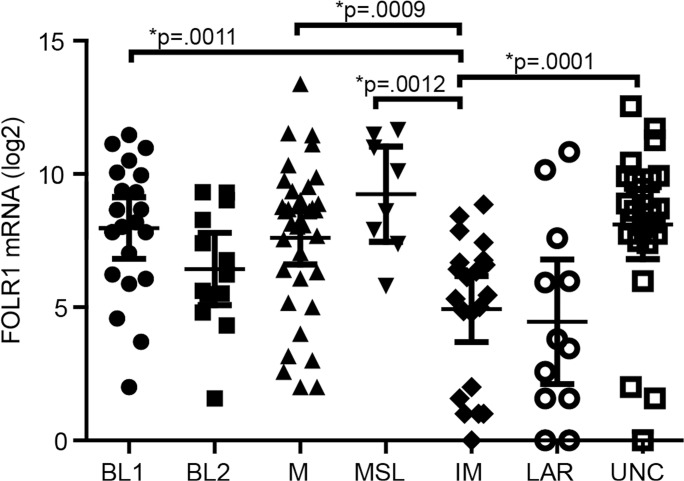
Distribution of FOLR1 tumor expression across TNBC tumor subtypes.
FOLR1 mRNA expression from 131 TN tumors from TCGA RNA-seq dataset were plotted versus the six TNBC subtypes that include basal-like (BL1 and BL2), immunomodulatory (IM), mesenchymal (M), mesenchymal stem-like (MSL), and luminal androgen receptor (LAR) reported by Lehman et al. [9]. Tumors were assigned to an unclassified group (UNC) if they had low correlations (<0.1) for any subtype or were similar between multiple subtypes (P<.05) [9]. Statistical significance across groups was determined by ANOVA Kruskal-Wallis test followed by Dunn’s Multiple Comparison Post test. *Significance at the P values shown was confirmed by Mann Whitney test of IM versus BL1, BL2, M, MSL, and LAR subtypes.